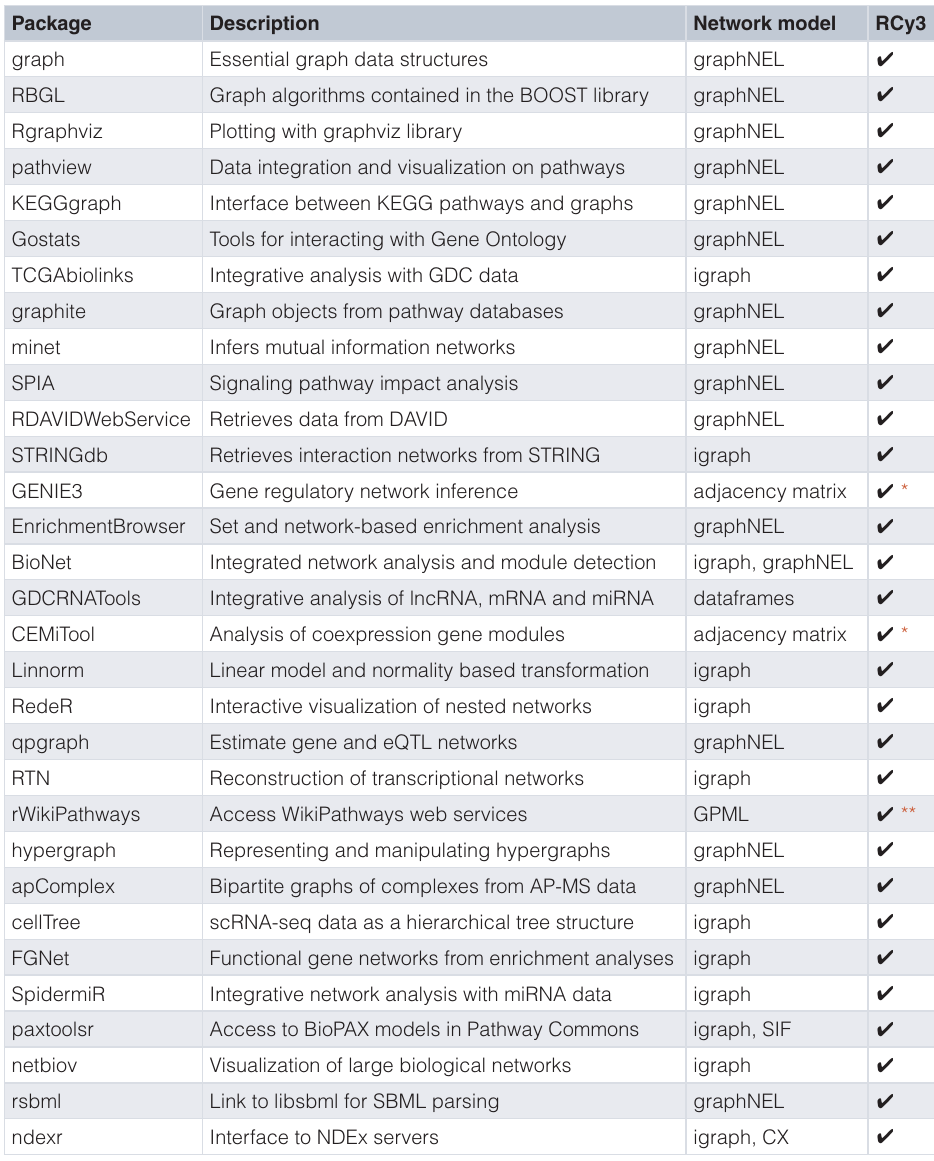
Table 2. Top 31 network-related Bioconductor packages ordered by rank (as of Sept 2019) and their network models relevant to RCy3. RCy3 can provide and consume network models to and from these packages (checkmarks). Asterisks indicate where a Cytoscape app is required (* aMatReader, **